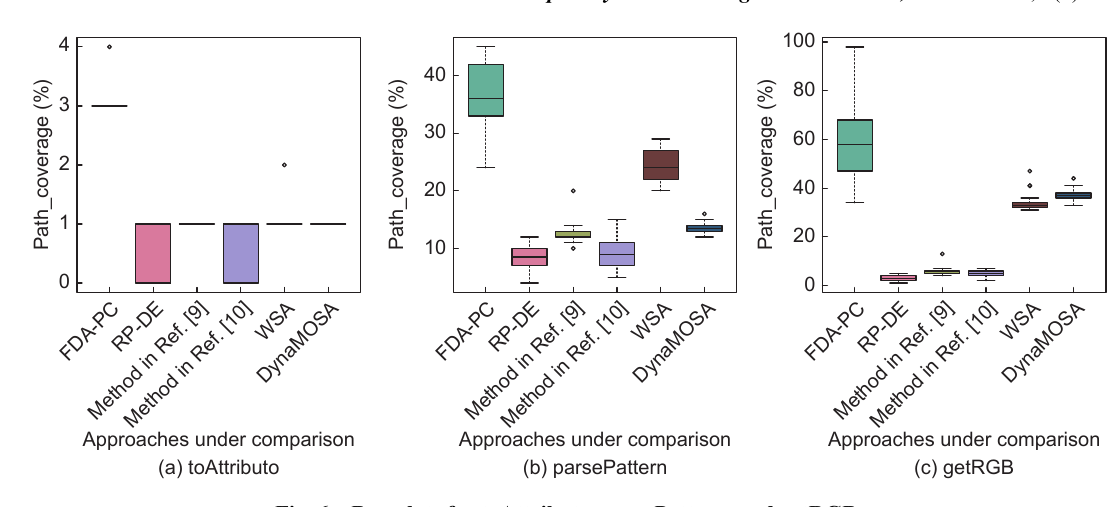
Fig. 6 Box plots for toAttributo, parsePattern, and getRGB. Table 5 Mean path_coverage, standard deviation, effect size, and statistical significance achieved by FDA-PC and No-FDA. Function